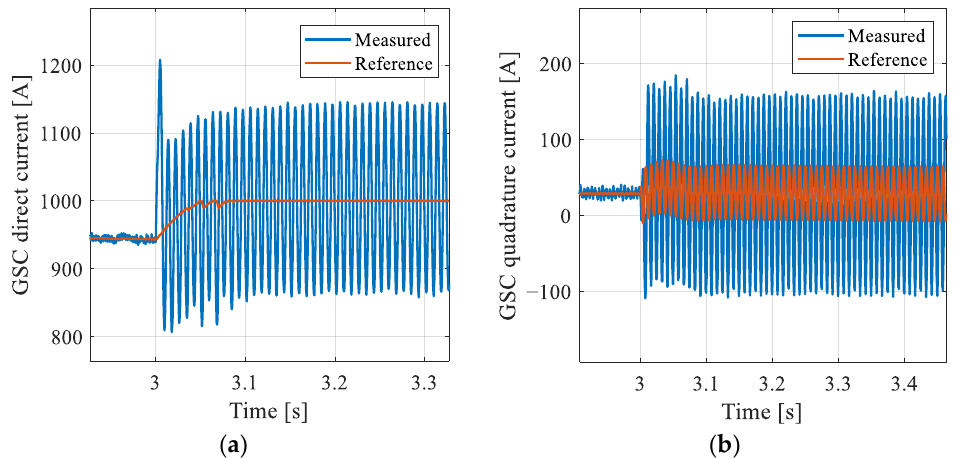
Figure 14. GSC currents for an unbalanced voltage sag of 20%: ( a ) d axis component and ( b ) q axis component.